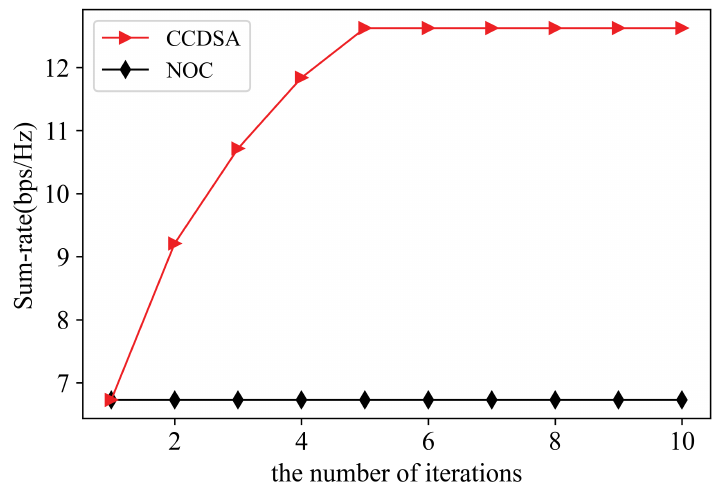
Figure 4. Convergence Analysis of CoMP clustering and dynamic spectrum allocation (CCDSA).